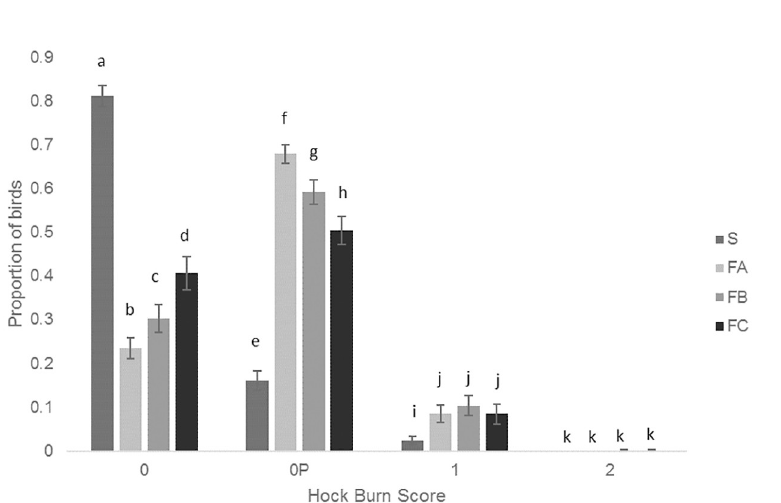
Fig 6. Mean proportions ( ± SEM) of the different hock burn scores for the four different breeds. Different letters denote signicant differences (P <